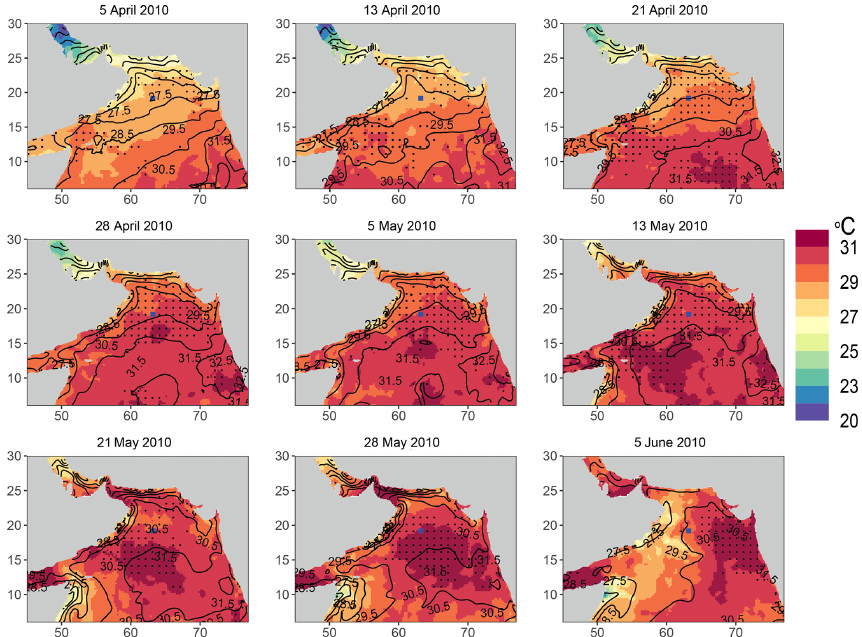
Figure 8. Evolution of observed SST (shading; daily averaged) with model-simulated SST overlaid (contour) during April–June 2010. Regions experiencing MHWs are marked by stippling. The blue dot in the north–central Arabian Sea (19 ◦ N, 63 ◦ E) shows the location where the heat budget analysis was performed.